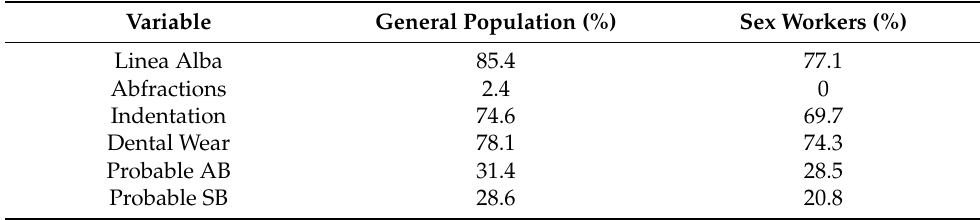
Table 5. Probable SB, probable AB and clinical signs supporting their